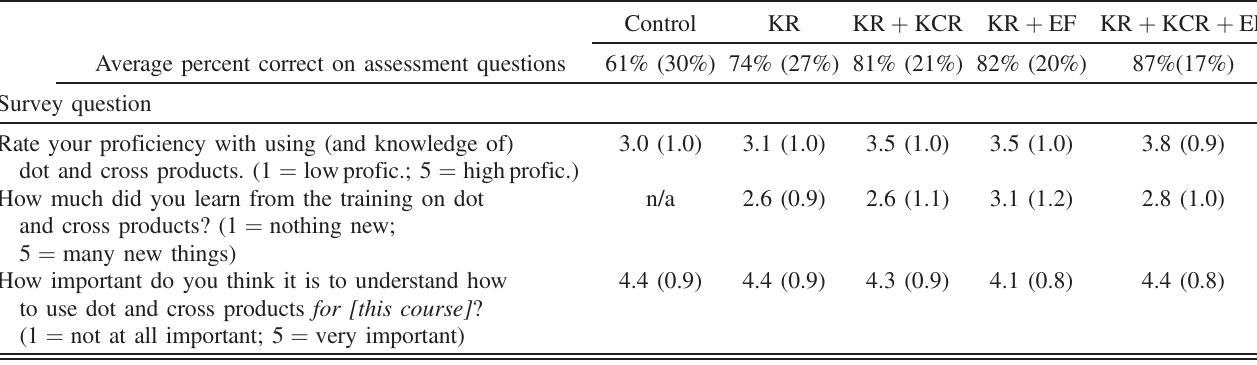
TABLE V. Mean student scores (percent correct) and mean student responses to attitudes and beliefs survey questions. Note that numbers in parentheses represent standard